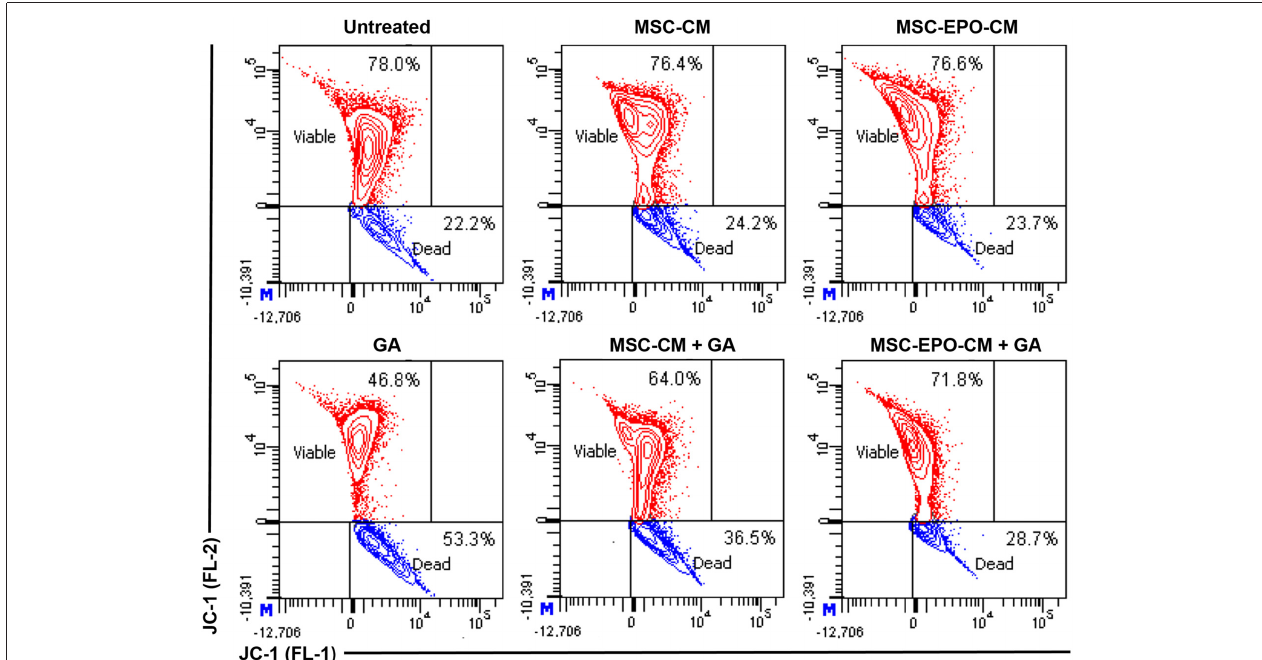
FIGURE 4 | Changes in the mitochondrial membrane potential ( ∆Ψ m) of glutamate-induced Y79 cells. (Upper panel) The status of the ∆Ψ m in the Y79 cells in the absence and (lower panel) presence of 67 mM glutamate was examined at 24 h after co-treatment with conditioned medium derived from non-transduced (MSC-CM) and EPO -transduced MSCs (MSC-EPO-CM). Y79 cells exposed to the same concentration of glutamate solution in fresh MSCs culture medium was used as a control. JC-1 is a selective membrane dye that enters the negatively charged mitochondrial matrix and was used to measure changes in the ∆Ψ m. In a living cell, healthy mitochondria was polarized and JC-1 was rapidly taken up by such mitochondria. The increase uptake could lead to the aggregation of JC-1, which demonstrated red fluorescence when measured in the FL-2 channel of a flow cytometer. On the other hand, JC-1 did not accumulate in a dying cell and formed monomer. The monomers showed lower fluorescence in the FL-2 and increased fluorescence in the FL-1 channel. The flow cytometric analysis was shown in the contour plots.